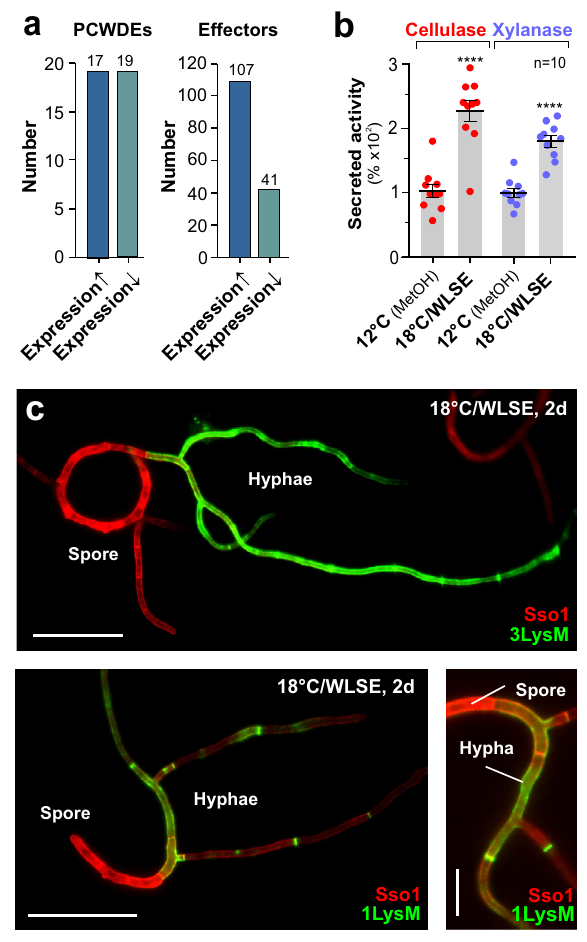
Fig. 5 | Evidence of PCWDEs and effector secretion in IPO323 hyphae grown in axenic culture. a Absolute number of genes, encoding putative plant cell wall- degrading enzymes (PCWDEs) and putative effectors (EffectorP2.0- and Signal P5.0-positiveorpublished)inIPO323hyphae,growninMMat18°C/WLSE.PCWDEs include putative cellulases, hemicellulases (incl. xylanases), pectinases and cuti- nases. b Activity of cellulases and xylanases in the supernatant of IPO323 cell cul- tures,grownfor2daysat12°C/MetOHor18°C/WLSE. c Appearanceof fl uorescent effector 3LysM (green, upper panel; FungiDB gene ID: ZTRI_11.155) and 1LysM (green,lowerpanels;ZTRI_8.414)inhyphaeemergingfromsporesgrowninMMfor 2 days at 18°C/WLSE. The plasma membrane is labelled with fl uorescent Sso1 27 (red). Scale bars=30 µ m (upper and lower left panel), 10 µ m (lower right panel). Results shown in ( c ) were obtained independently in 3 experiments. Bars in ( b ) represent mean±SEM, with n =10 biologically independent experiments; red dots represent individual experiments. Comparison with respective controls in used Student ’ s t -testing with Welch correction; ****signi fi cant difference at two-tailed P <0.0001.Forimageclarityin( c )mCherry fl uorescenceisgiveningreen,andGFP fl uorescencein red. All source data for ( b , c ) are providedin a Source Data fi le; for ( a ) see Supplementary Data